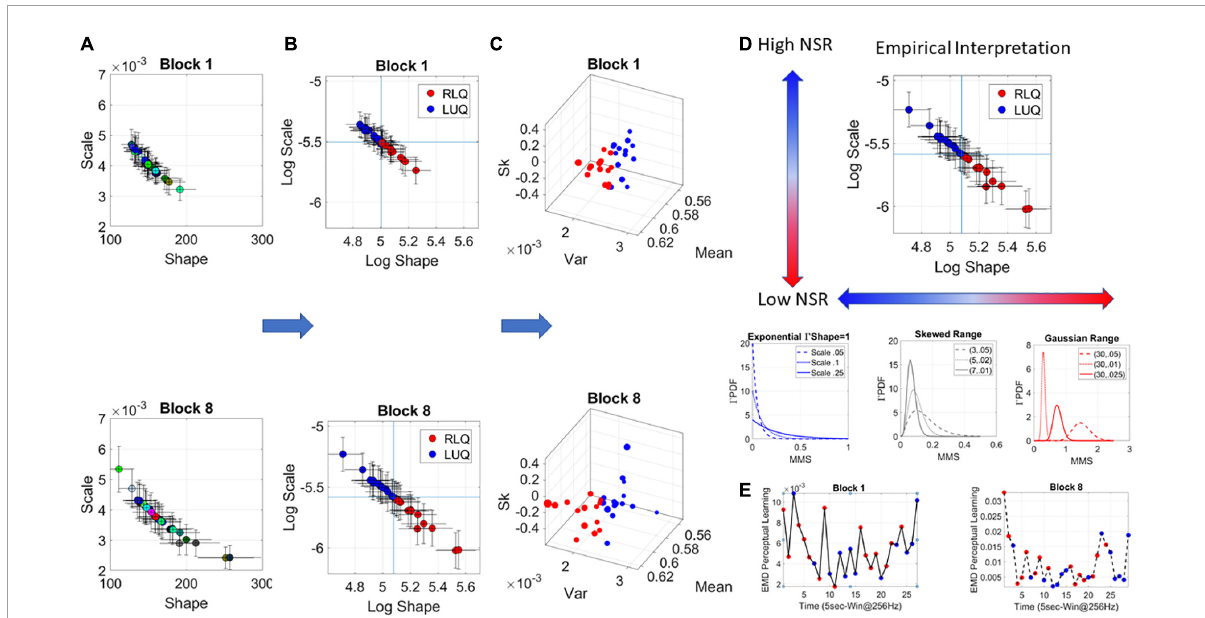
FIGURE3 Stochastic analyses of the MMS derived from hub’s activities. (A) Upon determination of the lead the MMS are obtained and MLE used to determine the parameters of the best continuous family of probability distribution functions (PDFs) describing their fluctuations. In this case the Gamma family. The Gamma shape and scale parameters thus estimated, are then plotted with 95% confidence intervals, on the Gamma parameter plane. (A) Each point represents the signatures of a 5-s window with 50% overlap. Colors represent arbitrary order. (B) The log–log Gamma parameter plane is obtained to track points according to the quadrants spanned by the median shape and median scale, taken across each block. The Right Lower Quadrant (RLQ) contrasts with the Left Upper Quadrant (LUQ). (C) The Gamma moments are obtained to visualize the points in (B) on a parameter space whereby the Gamma mean is represented along x-axis , the variance along the y-axis , the skewness along the z-axis and the size of the marker is proportional to the kurtosis. The color corresponds to the direction of the shift, where the point lands, red is from the LUQ to the RLQ, or from the RLQ to itself, whereas blue is from the RLQ to the LUQ, or from the LUQ to itself. (D) Empirical interpretation of the Gamma plane and the quadrants. Along the shape axis, the distributions change from the shape a = 1 memoryless exponential to the Gaussian range, with skewed distributions with heavy tails in between. (E) The EMD is used to track the magnitude of the shift from each estimated PDF in windows at t and t + 1, while the direction is tracked by the quadrant landing. This curve represents the evolution of the stochastic process and serves to determine, e.g., critical points of transitions for each block of the